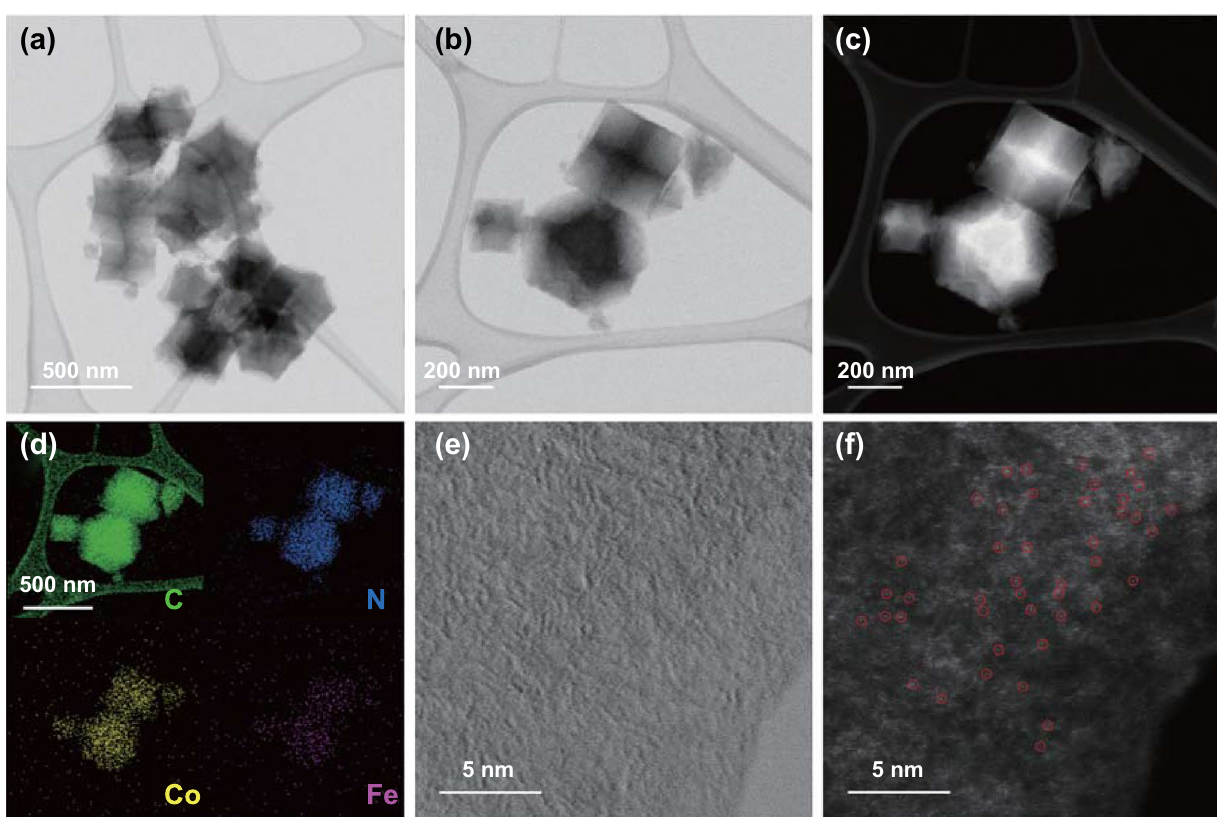
Fig. 2 a, b TEM images, c HAADF-STEM images, d elemental mapping images, e magnified TEM images, f atomic-resolution HAADF- STEM images of C–Fe–Co–ZIF-1.6 wt%-Fe